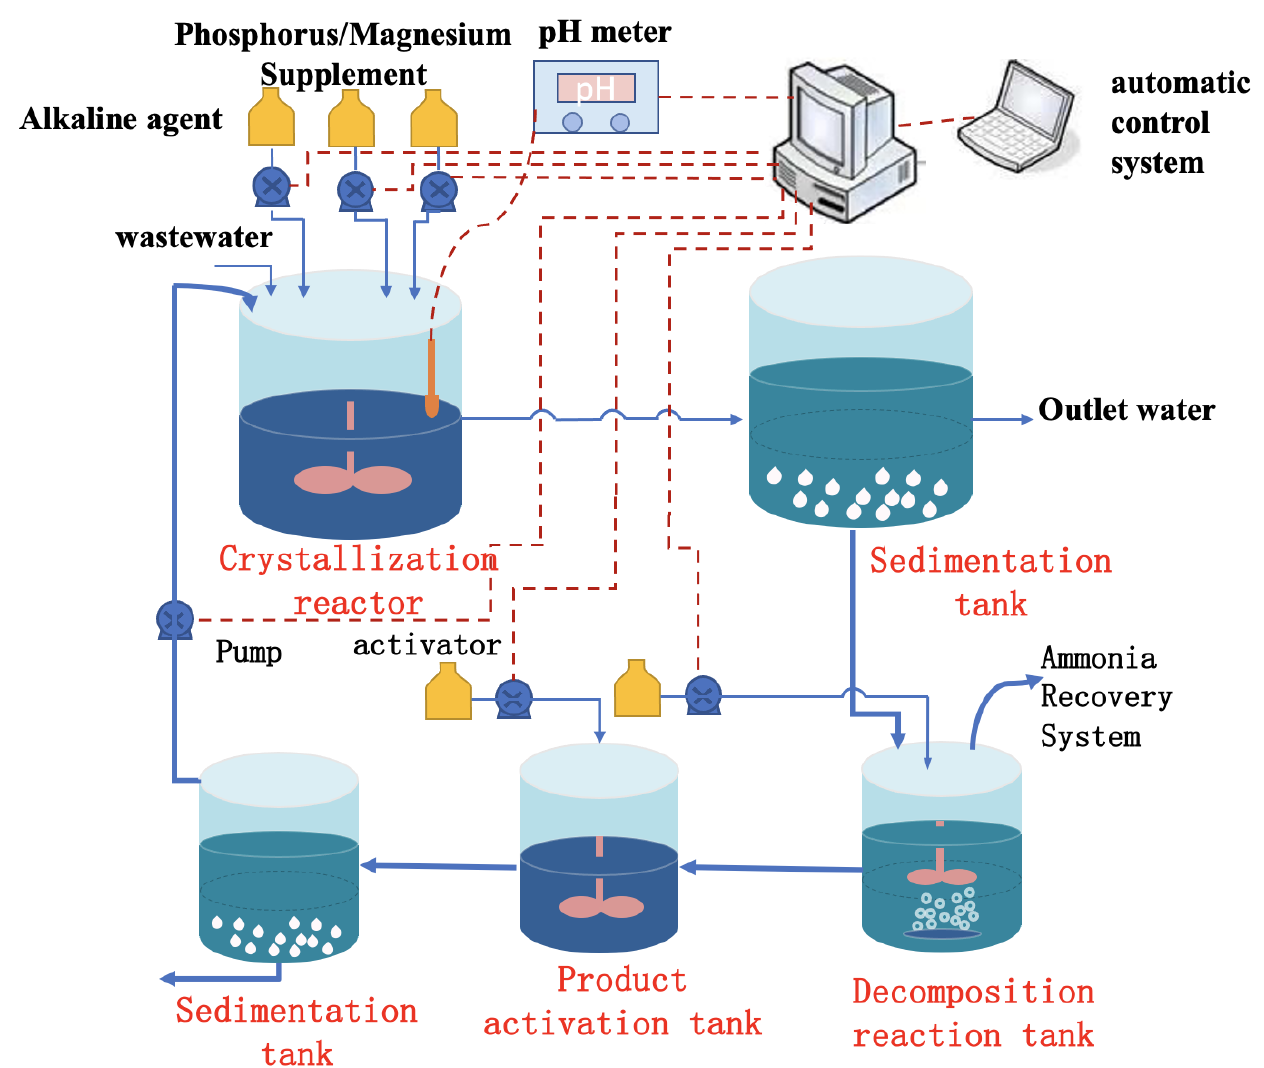
Figure 2. Schematic of the denitrification process by ammonium magnesium phosphate precipita- tion.